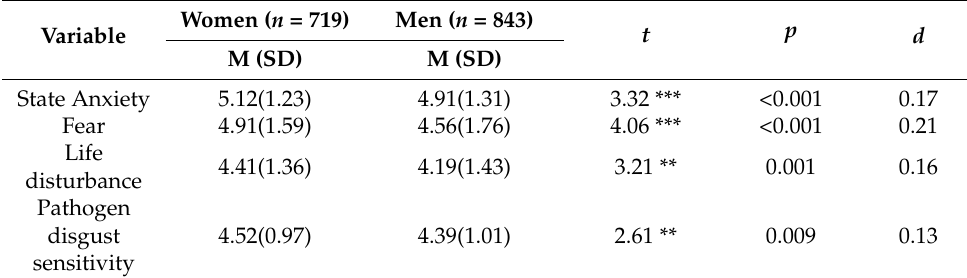
Table 3. Gender differences in state anxiety, fear, life disturbance, and pathogen disgust sensitivity.